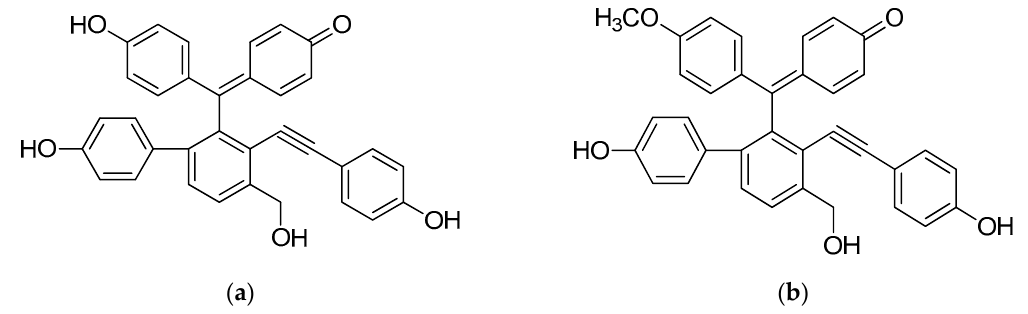
Figure 1. Chemical structures of selaginellin and selaginellin M from S. tamariscina : ( a ) Selaginellin; ( b ) Selaginellin M.